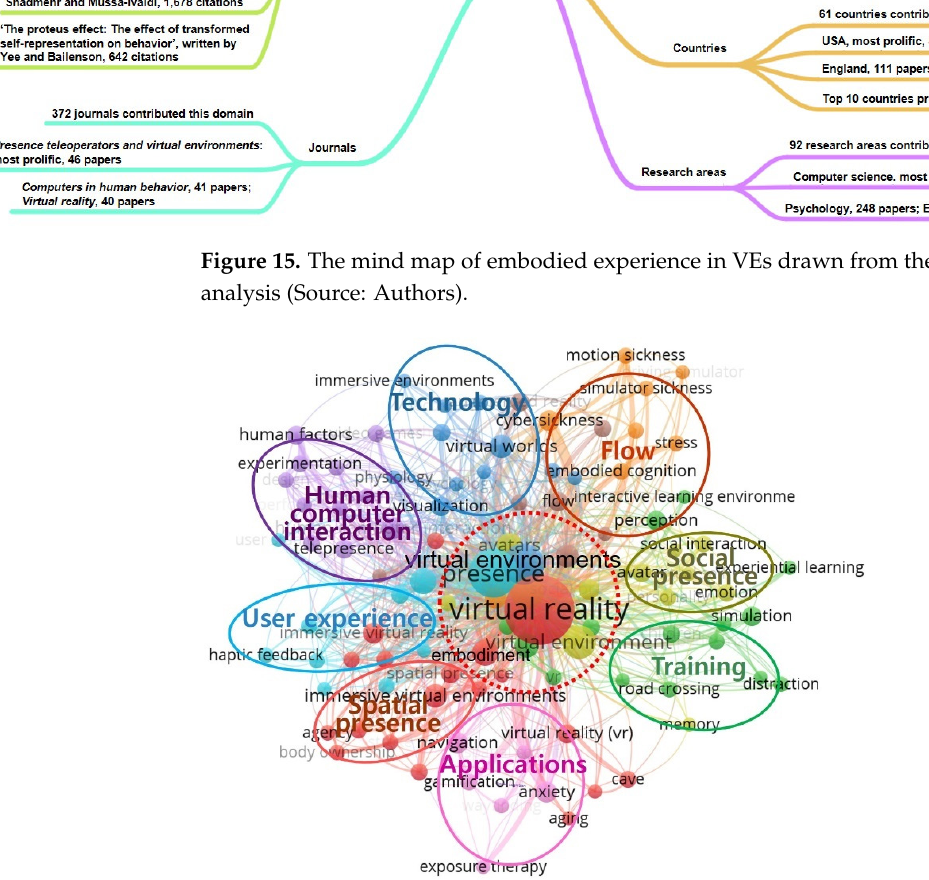
Figure 16. Classification of keywords into topics (Source: Authors).